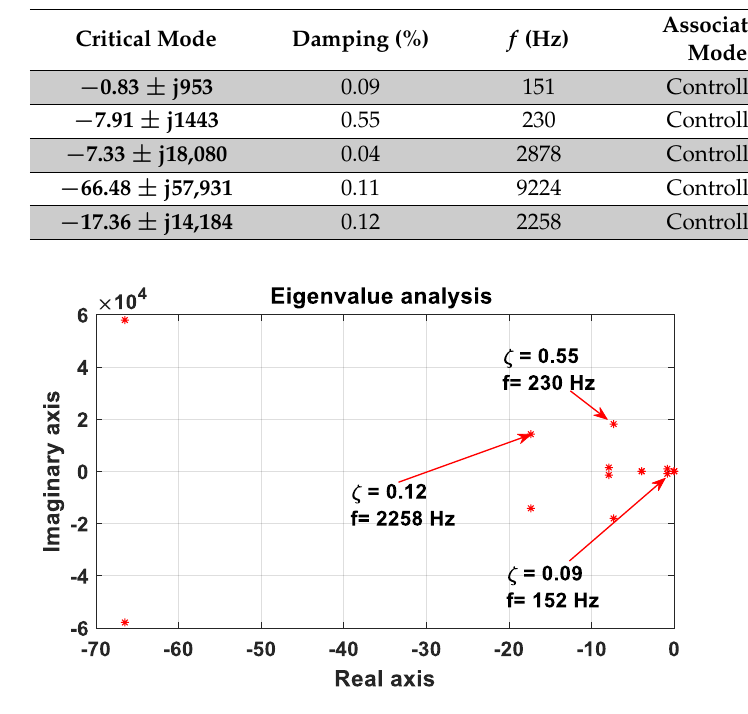
Figure 4. Eigenvalue analysis result — stable operation in DC grid.